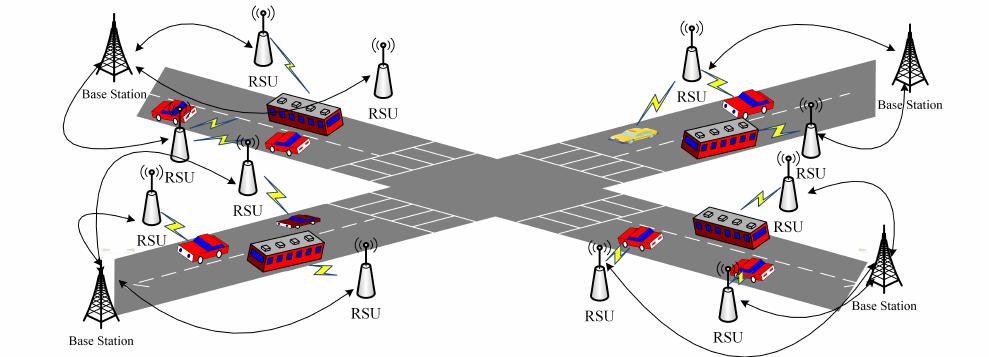
Figure 1. VANETs